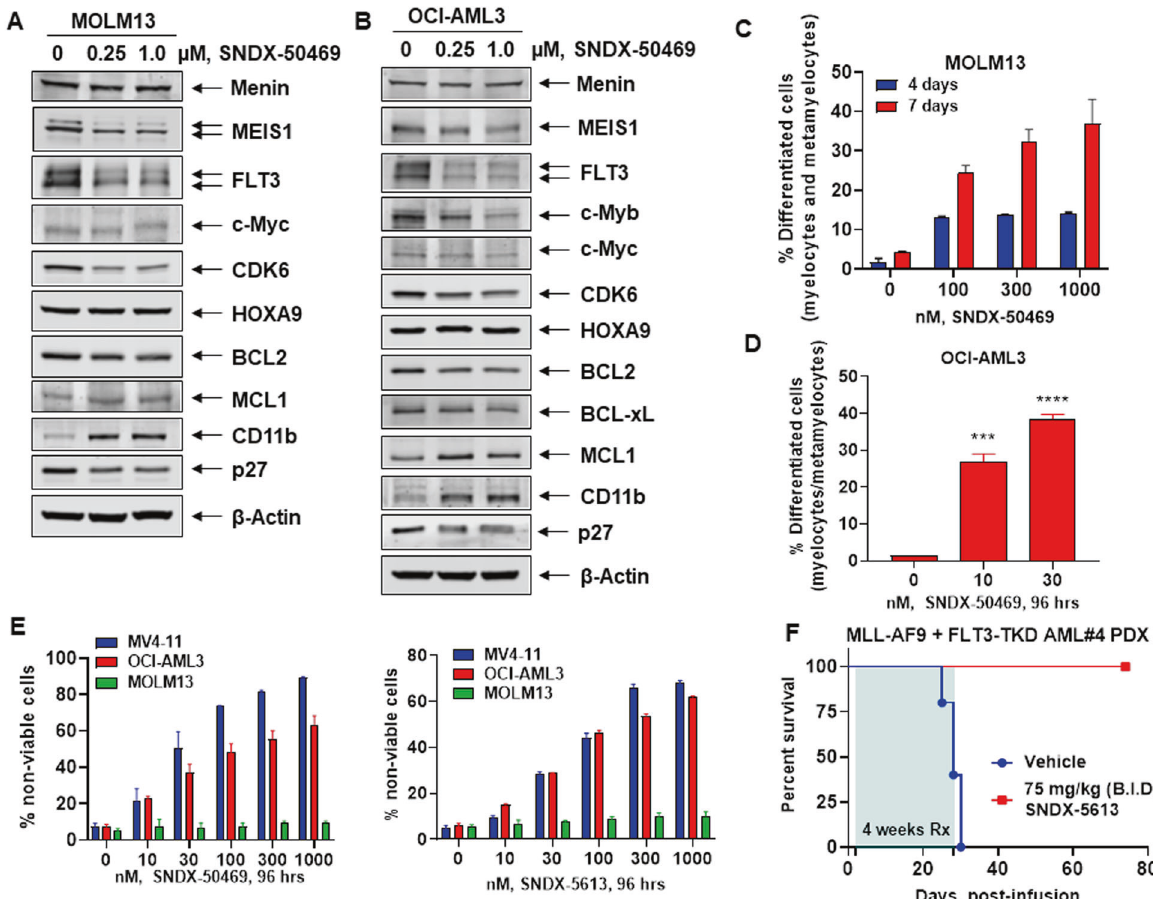
Fig. 2 Treatment with Menin inhibitor SNDX-50469 depletes MEIS1, FLT3, CDK6, and BCL2 with concomitant induction of MCL1 and CD11b expression and features of morphologic differentiation in AML cells. A , B MOLM13 and OCI-AML3 cells were treated with the indicated concentrations of SNDX-50469 for 48 h. Following this, total cell lysates were prepared and immunoblot analyses were conducted. The expression levels of β -Actin in the lysates served as the loading control. C , D MOLM13 and OCI-AML3 cells were treated with the indicated concentrations of SNDX-50469 for 96 h or 7 days. Morphologic differentiation (% myelocytes, meta-myelocytes, or bands) was determined by light microscopy. Mean of three experiments ±S.E.M. *** p < 0.005; **** p < 0.001 (determined by two-tailed, unpaired t test in GraphPad V8). E MV4-11, OCI-AML3, and MOLM13 cells were treated with the indicated concentrations of SNDX-50469 or SNDX-5613 for 96 h. At the end of treatment, the % of TO-PRO-3 iodide-positive, non-viable cells were determined by fl ow cytometry. Columns, mean of three experiments ±S.E. M. F Kaplan – Meier survival curve of mice infused with MLL-AF9 + FLT3-TKD expressing PDX (AML#4) cells and treated with SNDX-5613 as indicated for 4